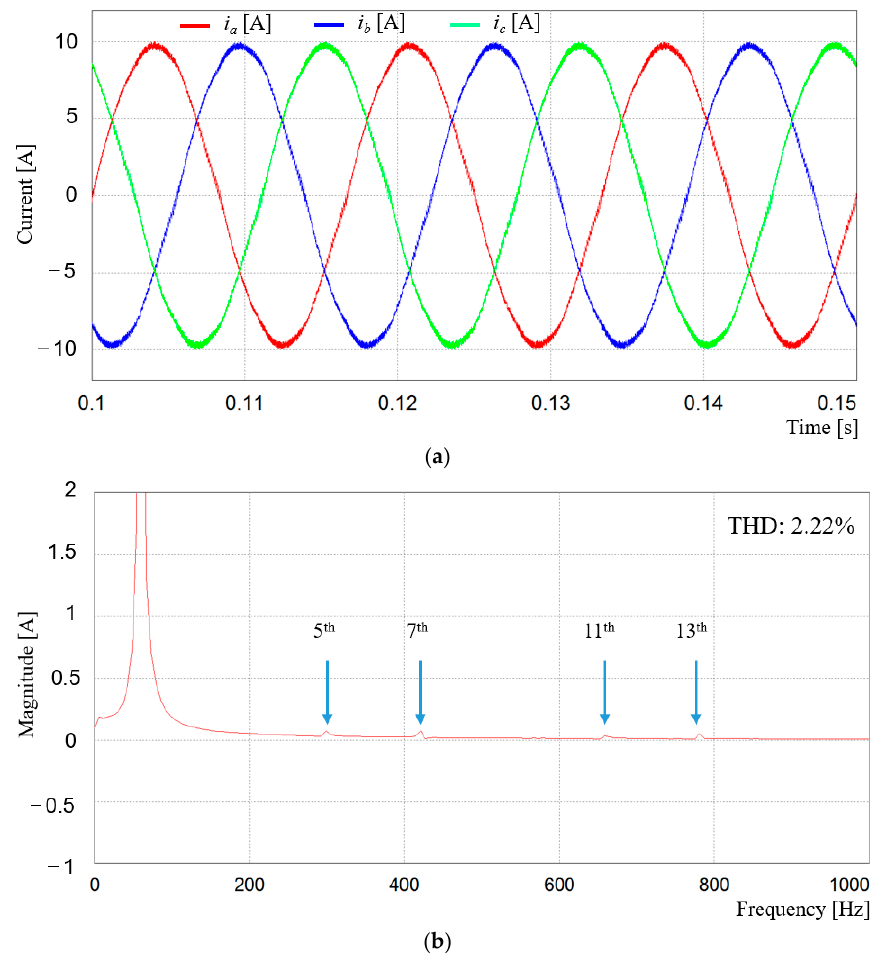
Figure 6. Inverter currents of the PR controller under distorted grid voltages. ( a ) Phase currents; ( b ) FFT result of a -phase current.